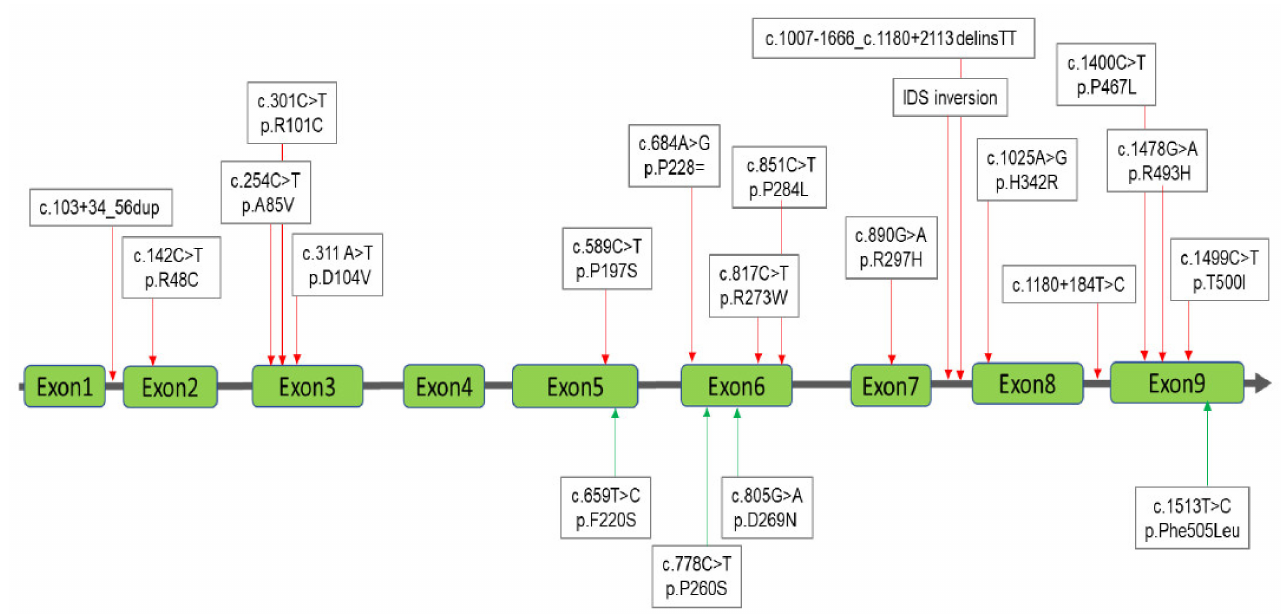
Figure 3. A total of 21 mutations of the IDS gene underlying Taiwanese Hunter syndrome were found; of those 17 had been reported previously (red lines with arrows) and the other four were novel mutations (green lines with arrows).